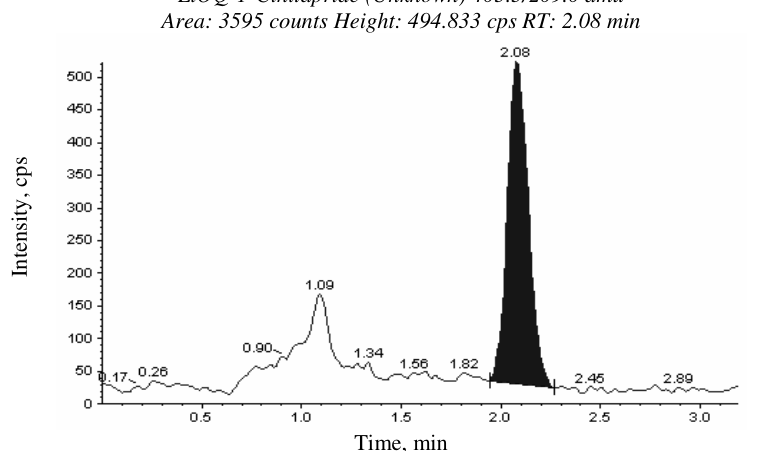
Figure 2. Representative chromatograms plasma spiked with cinitapride drug at the lower limit of